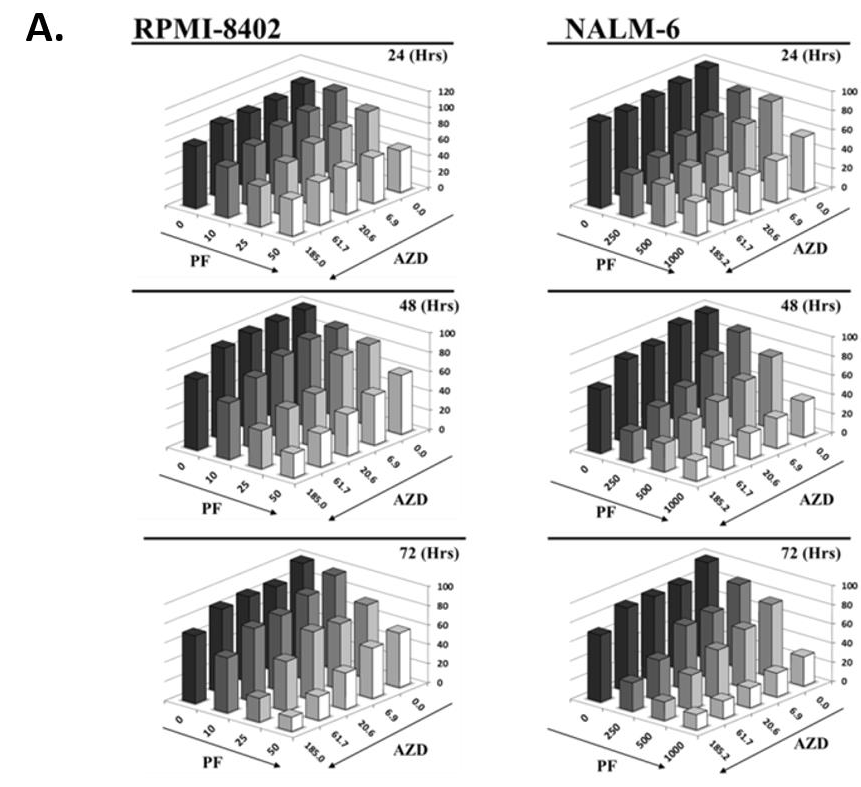
Figure 1. Cont Figure 1. Cont.